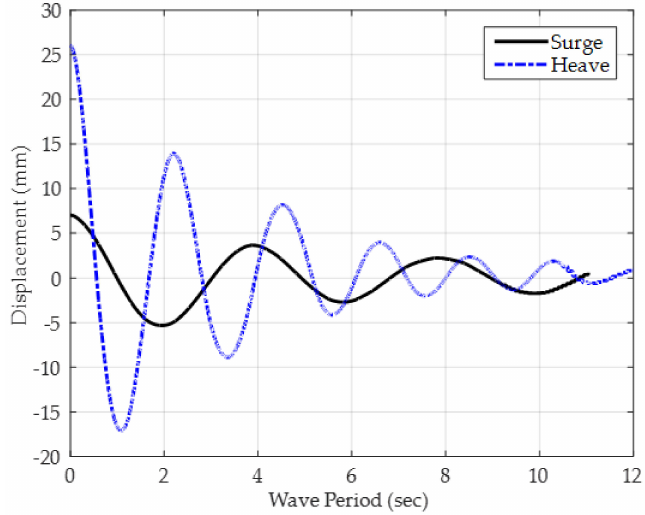
Figure 6. Decay curves for surge and heave motions of rigid body 1 with the use of the computational fluid dynamics model (CFDM). Table 2. p and q damping coefficients for the examined motions and two different velocity regions VR 1 and VR 2 .